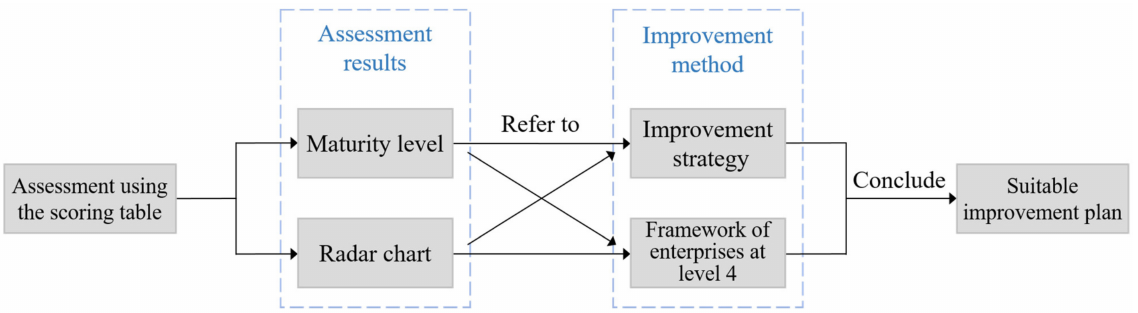
Figure 7. Method to obtain suitable improvement